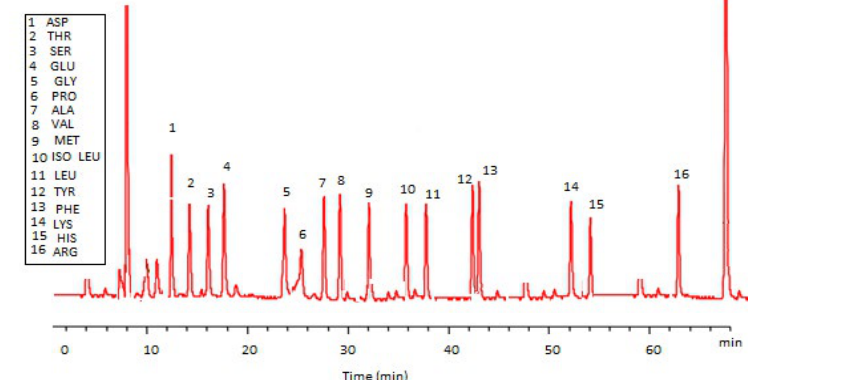
Fig. 16. HPLC analysis of total protein content of Penicillium